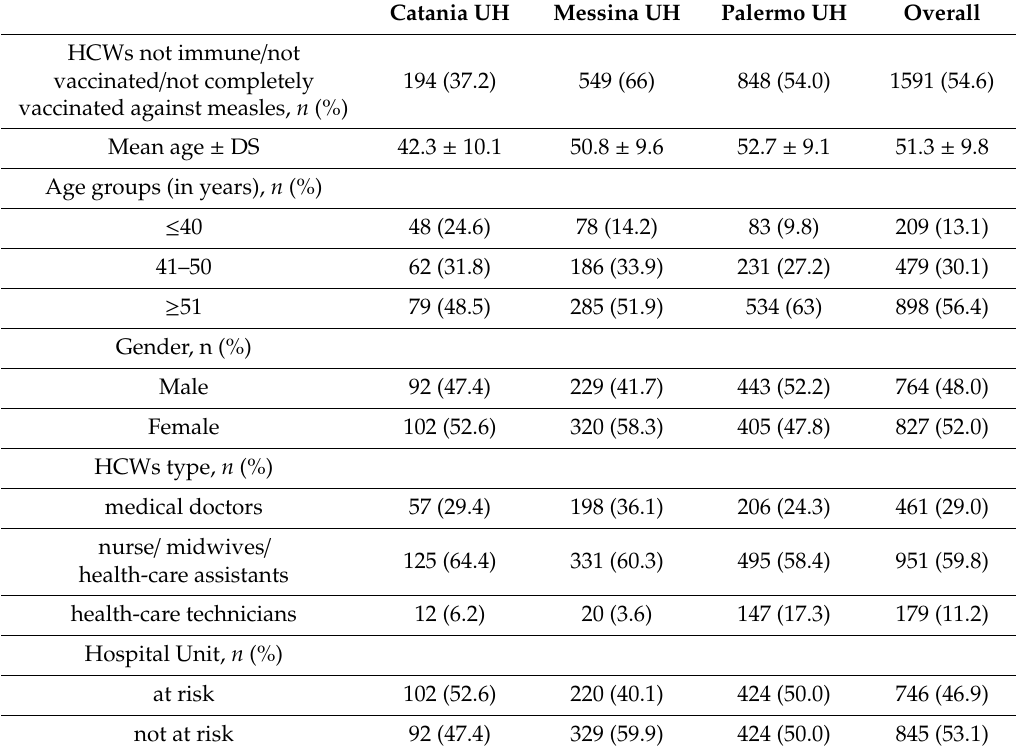
Table 3. Socio-demographics and working characteristics of HCWs not naturally or artificially immune, not completely immunized (received only one dose), and that do not know or remember their vaccination / immunization status against measles at the three Sicilian UHs ( n =